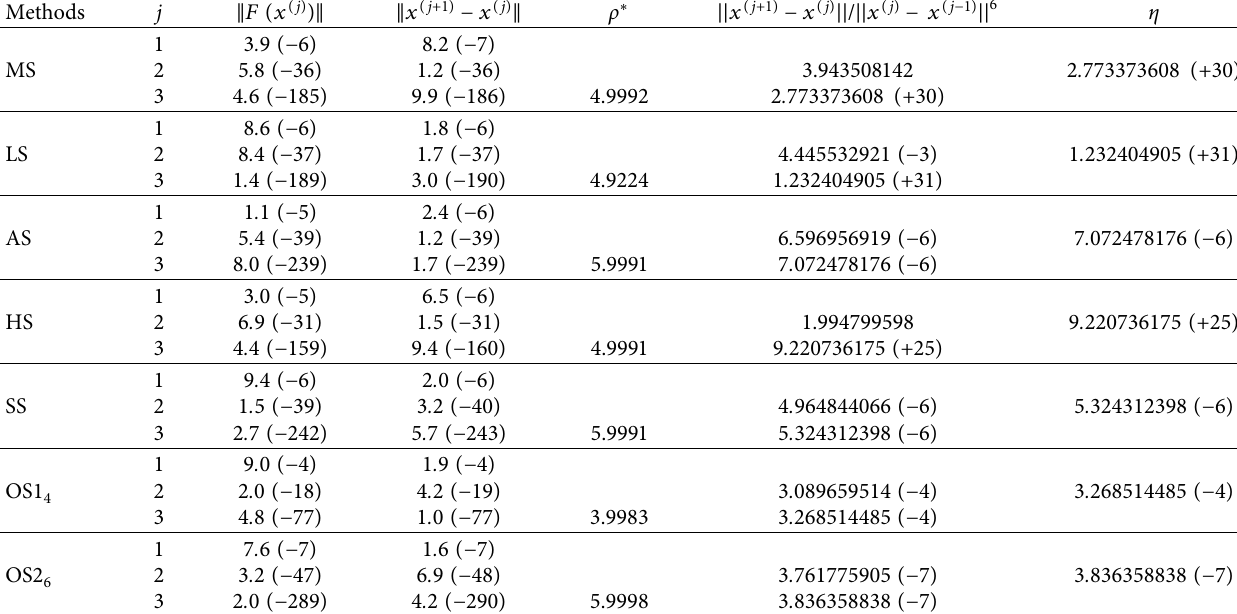
Table 4: Convergence behavior of different methods on Hammerstein integral equation